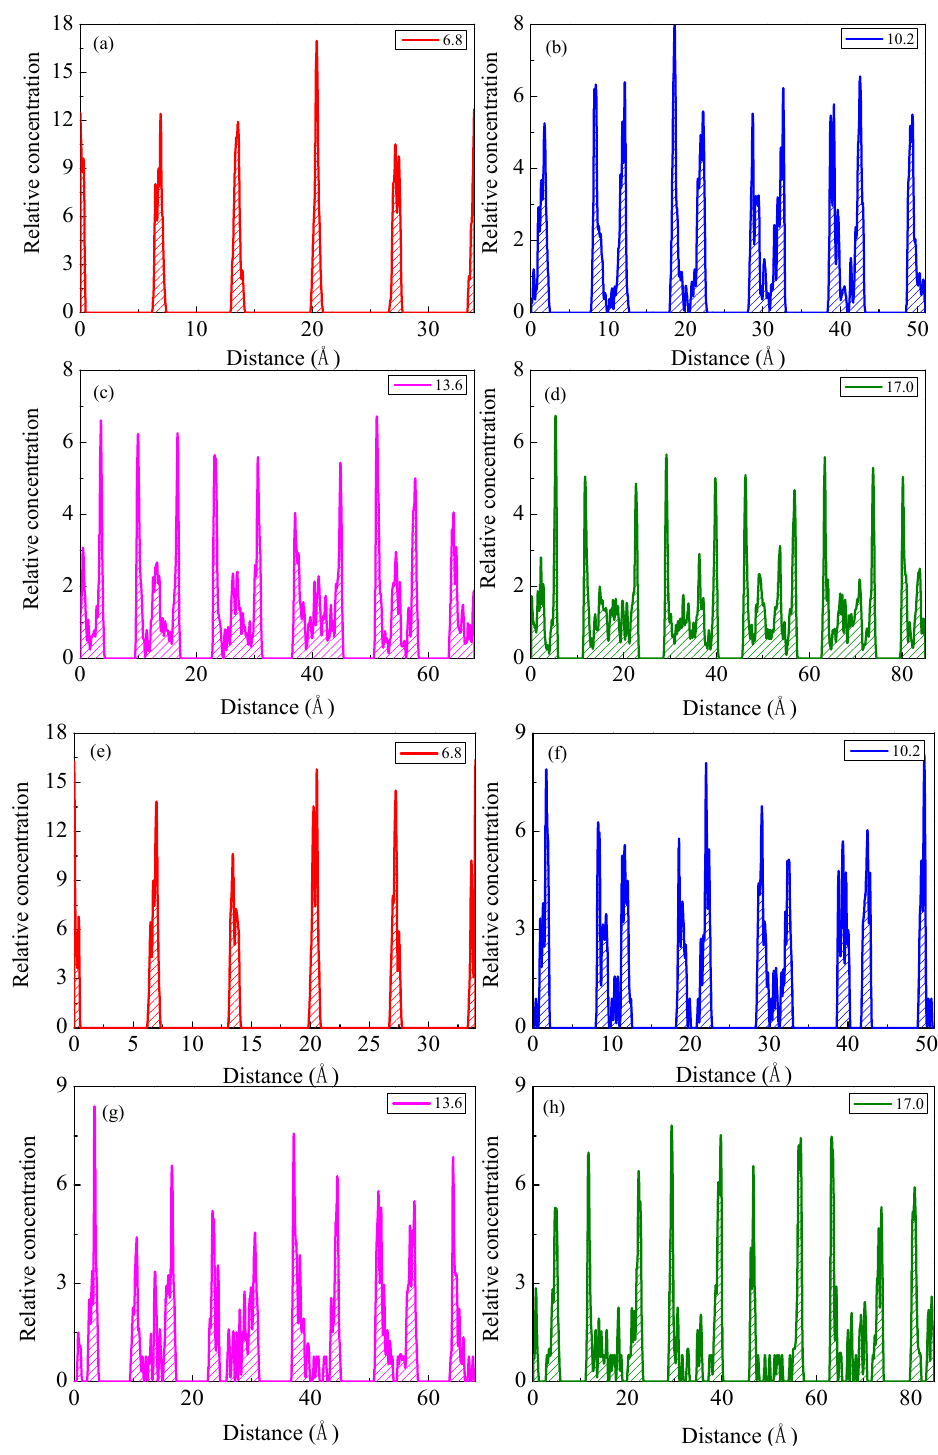
Figure 7. The relative concentration profiles of CO 2 ( a – d ) and N 2 ( e – f ) as a function of the layer distance in their equilibrium states.